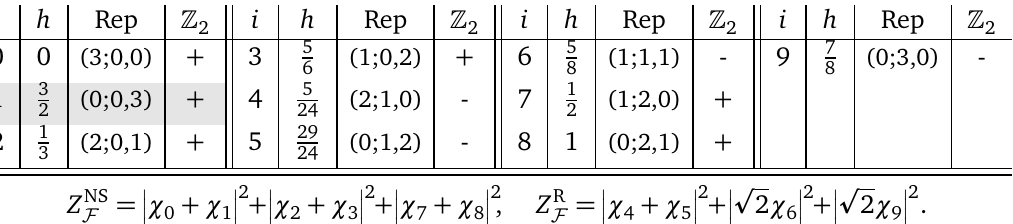
Table 13: Sp ( 4 ) : primaries labeled by i are characterized by weights h and Sp ( 4 ) Dynkin labels. 3 ( τ ) . We highlight the primary related to the center symmetry Their characters are denoted by χ i (cid:90) . 2